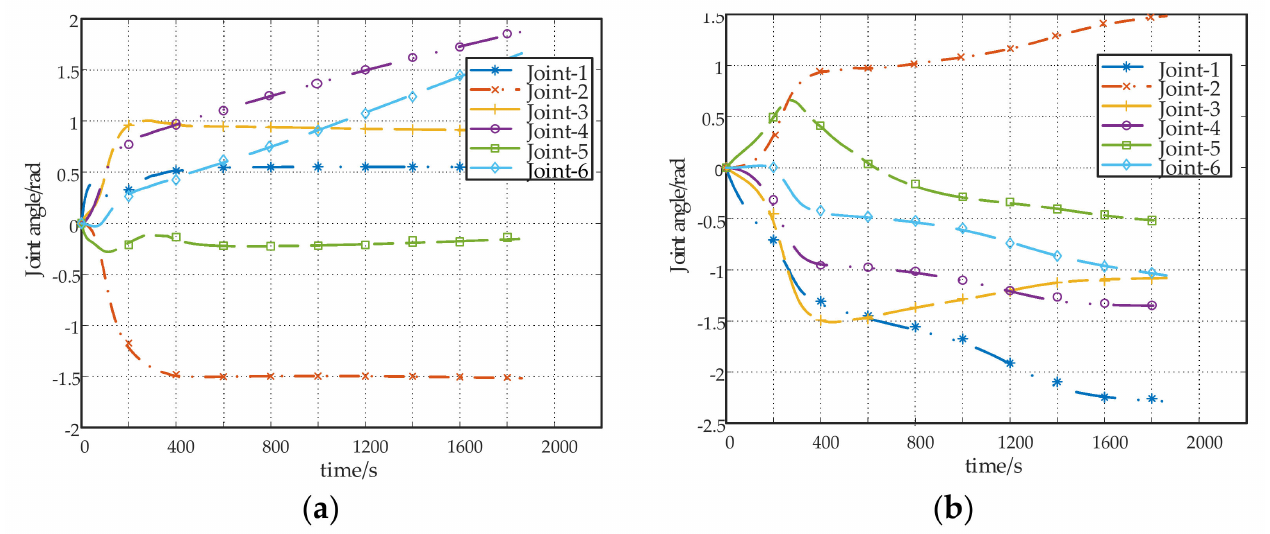
Figure 9. Results of obstacle avoidance with VP-APF. ( a ) Variation of each joint angle of the left arm of the robot during collision avoidance; ( b ) variation of each joint angle of the right arm of the robot during collision